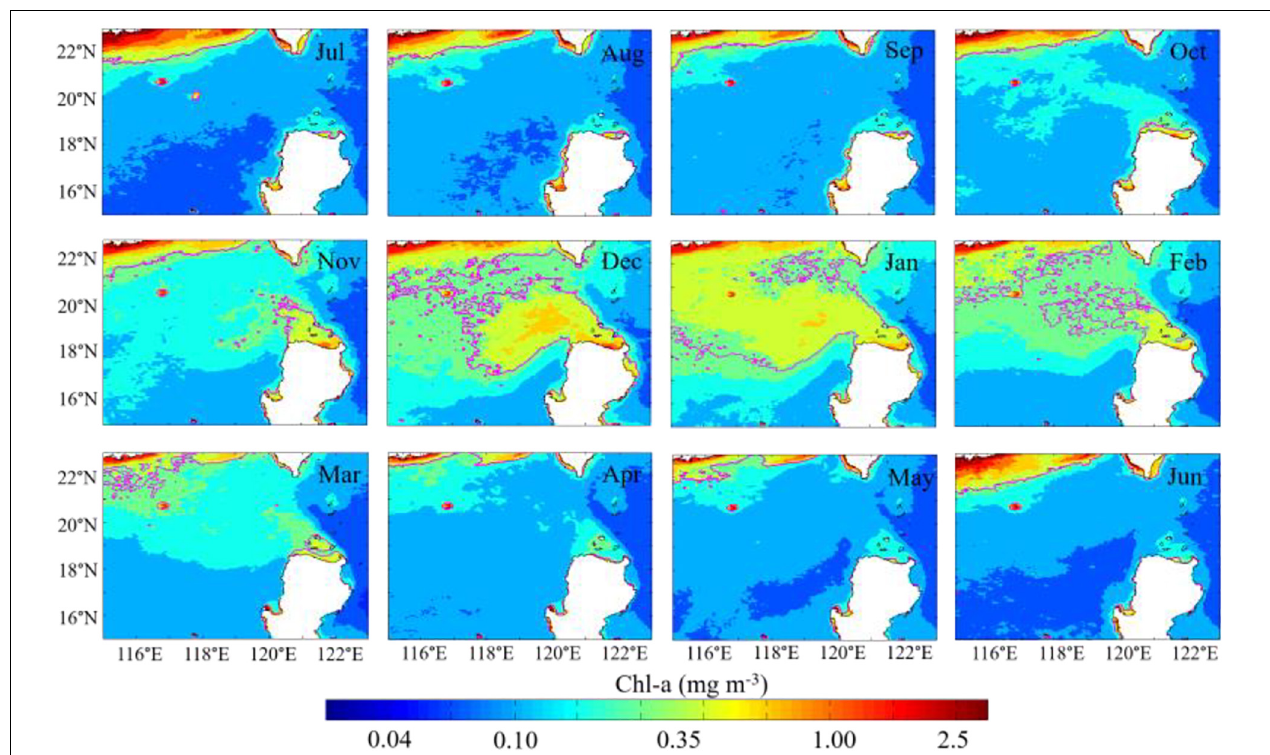
FIGURE 2 | Monthly mean merged Chl- a concentration with a spatial resolution of 4 km in the period 1999–2015. Magenta contours depict the Chl- a concentration is 0.35 mg m − 3 .